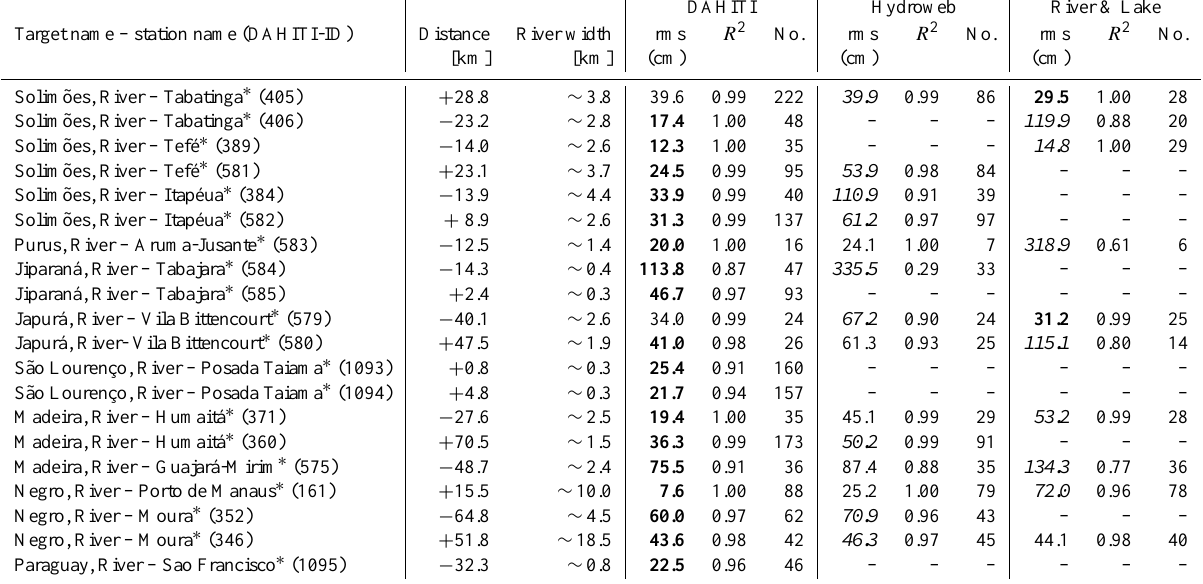
Table 5. Water level time series of selected rivers of the Amazon Basin from DAHITI, Hydroweb and River & Lake compared with in situ data. For each comparison of water level time series from altimetry with in situ data an rms difference and squared correlation is computed. The number of points from the final water level time series which were used for the validation is given in the third column (No.) of each altimeter data set. Additionally, the distance to the nearest in situ station (upstream ( + ), downstream ( − )) and the river width at the crossing altimeter track is shown. The smallest rms difference for each target is highlighted in bold, the largest one in